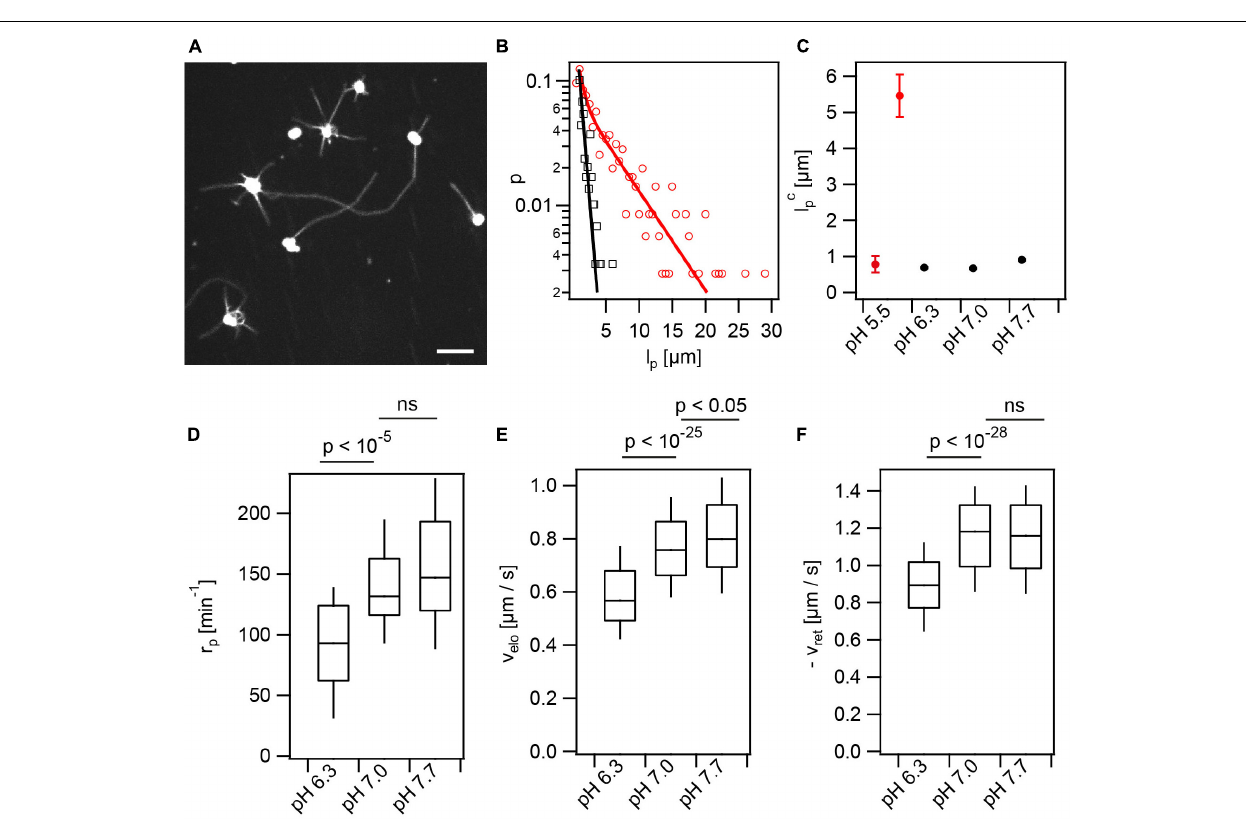
FIGURE 6 | Extracellular pH affects T4P dynamics. In the presence of lactic acid, the external pH was adjusted to different values. (A) At pH 5.5 T4P appear elongated. Scale bar: 5 µ m. (B) Distribution of maximal T4P lengths at pH 5.5 with double exponential fit (red) and pH 7.0 with exponential fit (black). (C) Characteristic maximal T4P length at varying pH. The characteristic length was determined from an exponential fit for pH 6.3–7.7. At pH 5.5, the two characteristic lengths obtained from the double-exponential fit are shown. ( > 247 T4P for each condition) (D) Rate of T4P production, r p ( > 32 cells for each condition). (E) T4P elongation velocities, v elo ( > 87 T4P for each condition). (F) T4P retraction velocities, v ret ( > 100 T4P for each